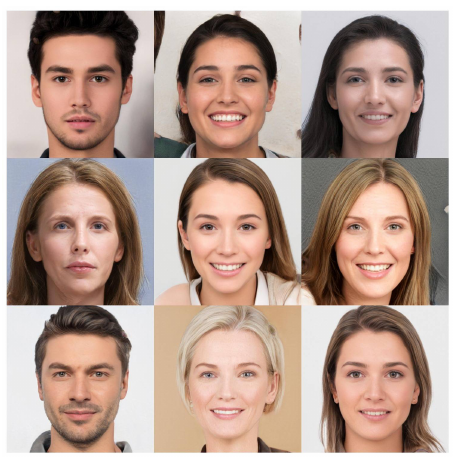
Figure 12. Images example.